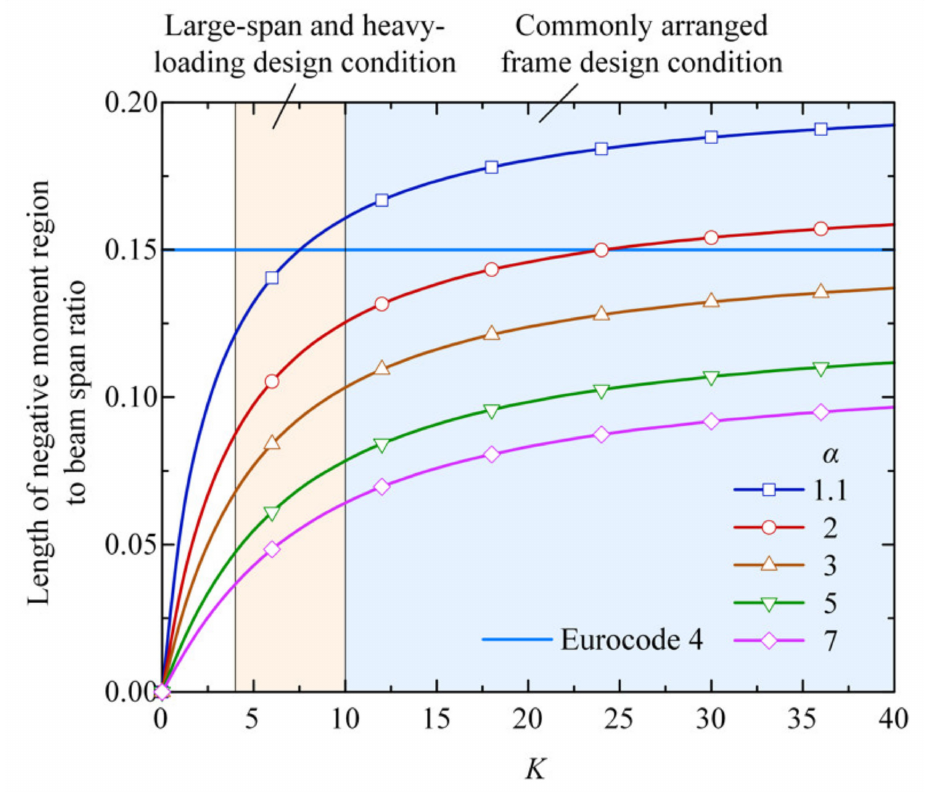
Figure 6. Variation in the length of the negative moment region with critical parameters K and α